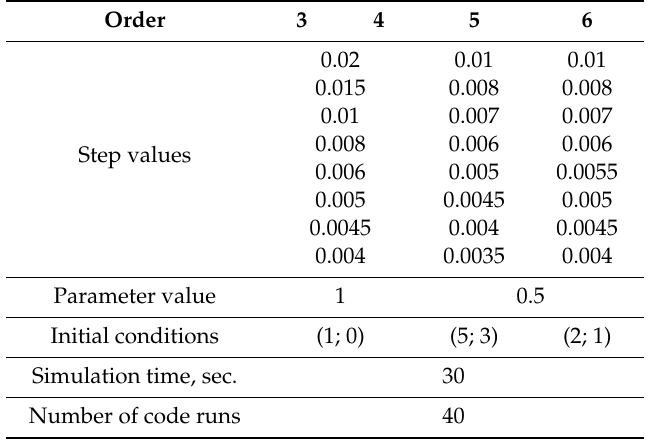
Table 6. The parameters used for experiments with the van der Pol system.